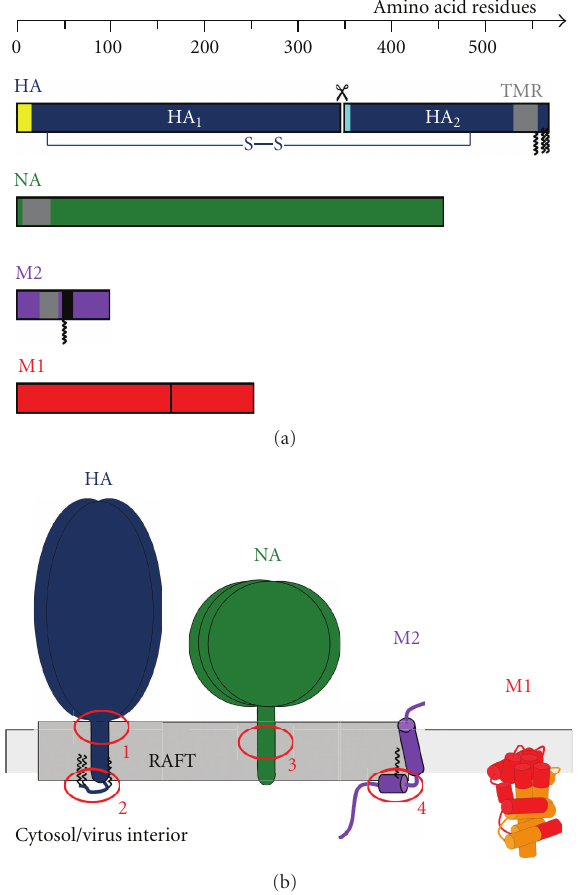
Figure 1: The membrane-associated proteins of influenza virus and their raft association. (a) Primary amino acid sequence of hemag- glutinin (HA, processed into HA 1 and HA 2 , blue), neuraminidase (NA, green), M2 (purple), and M1 (red, with amphiphilic helix in black). Transmembrane regions (TMR) in gray, S-acylations in HA and M2 indicated by zigzag line, signal peptide of HA in white, and fusion peptide in HA in cyan. (b) Topology of HA, NA, M2, and M1 in the membrane, raft localization indicated. Raft-targeting features: (1) hydrophobic amino acids in the outer part of the HA-TMR; (2) S-acylation of HA; (3) outer part of the NA-TMR; (4) S-acylation and cholesterol binding of the amphiphilic helix of M2. M1 according to the structure model of Shishkov et al. [1], membrane-interactive regions in red. Only one monomer of the trimeric HA and the tetrameric NA and M2 is shown for